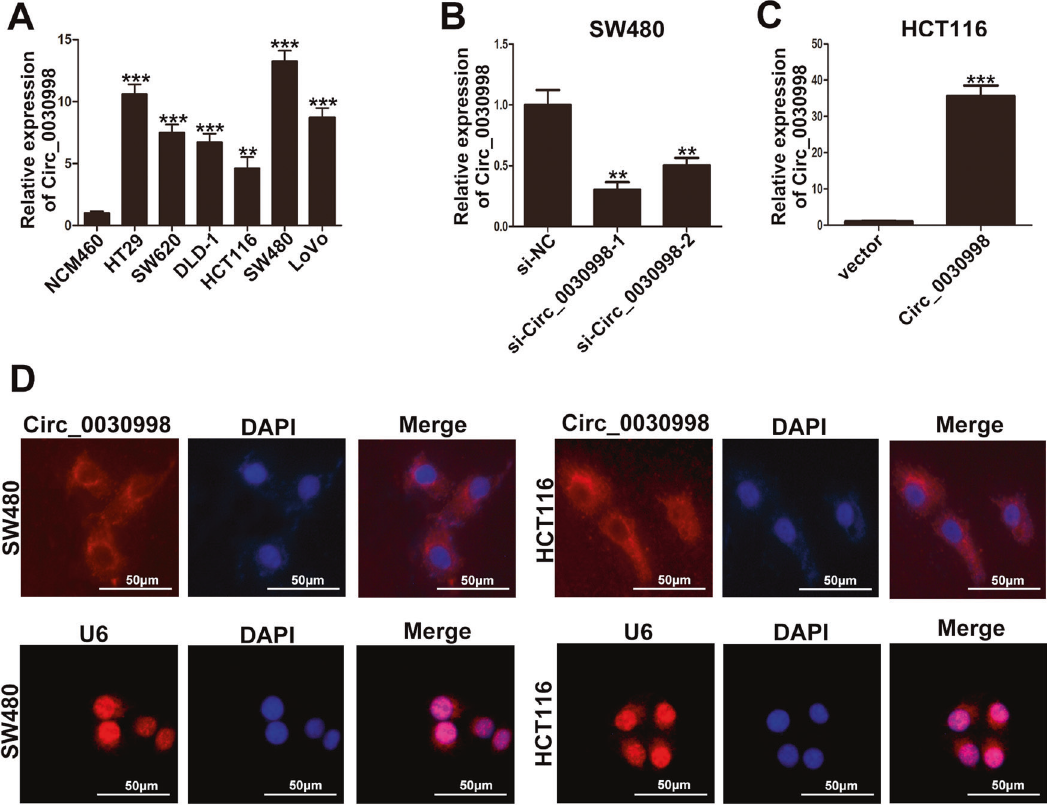
Fig. 2 Circ_0030998 was upregulated in CRC cell lines and mainly localized in the cytoplasm of CRC cells. A Relative expression of Circ_0030998 in CRC cell lines and human non-tumorigenic colorectal epithelial cell line NCM460 determined by qRT-PCR. B The ef fi ciency of siRNAs of Circ_0030998 in SW480 cells examined by qRT-PCR. C The ef fi ciency of Circ_0030998 overexpression plasmid in HCT116 cells examined by qRT-PCR. D FISH images of Circ_0030998 expression in SW480 and HCT116 cells (red) (U6 as control). Nuclei were stained by DAPI (blue). ** p < 0.01, *** p <